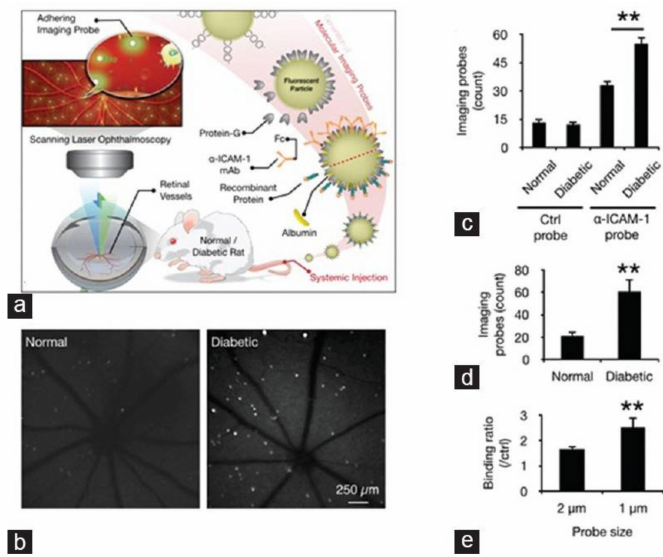
Figure 5. Figure 5. In vivo detection of endothelial injury using molecular imaging. ( a ) Schematic of in vivo molecular imaging approach; ( b ) Representative SLO-micrographs from the retinas of normal and diabetic animals. White dots represent firmly adhering probes; ( c ) In vivo probe adhesion in normal and three-week diabetic animals ( n = 5, ** p < 0.01); ( d ) Molecular imaging of retinal endothelial ICAM-1 in 6 diabetic animals ( n = 6, ** p < 0.01); ( e ) Comparison between the binding of two